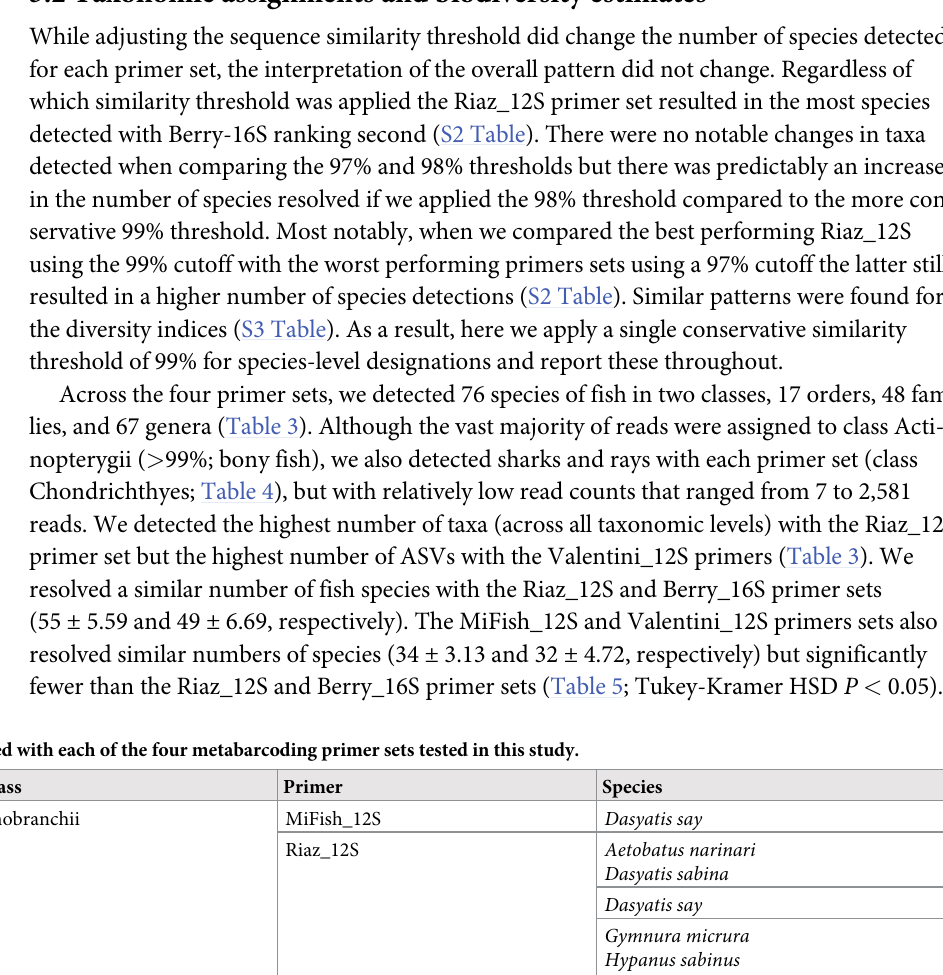
Classes include Actinopterygii and Chondrichthyes.